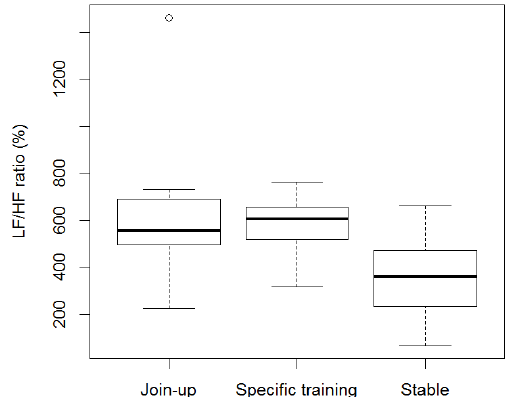
Figure 6. LF/HF ratio of horses before training (Stable), during their first Join-Up ® (Join-up) and during the rest of the training session (Specific training). No statistical difference was observed between first Join-Up ® (Join-up) and during the rest of the training session (Specific training). Analysed using generalized linear mixed models (GLMM) and the Wilcoxon signed-rank test.